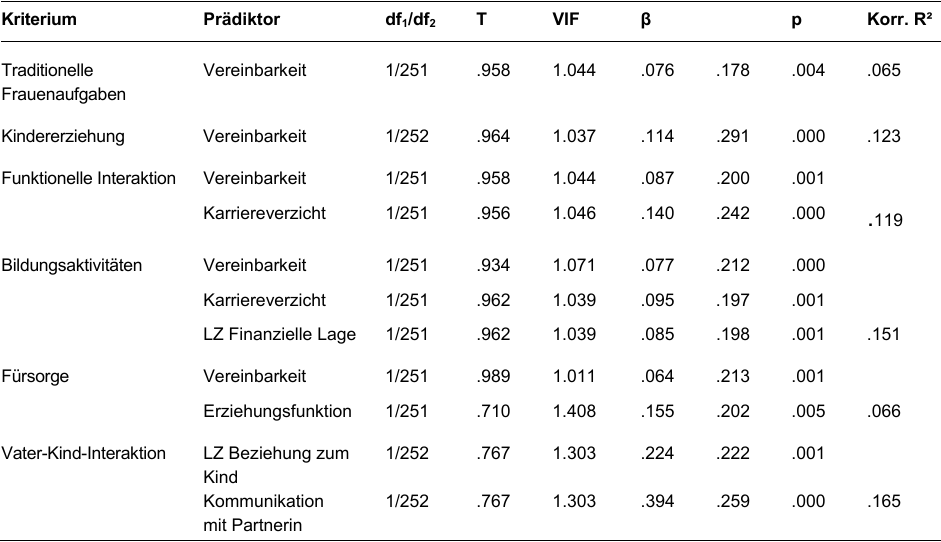
Tabelle 4 : Signifikante Prädiktoren (nach Bonferroni-Korrektur) der multiplen Regres- sionen für Bereiche der väterlichen Aufgabenübernahme und für die Vater-